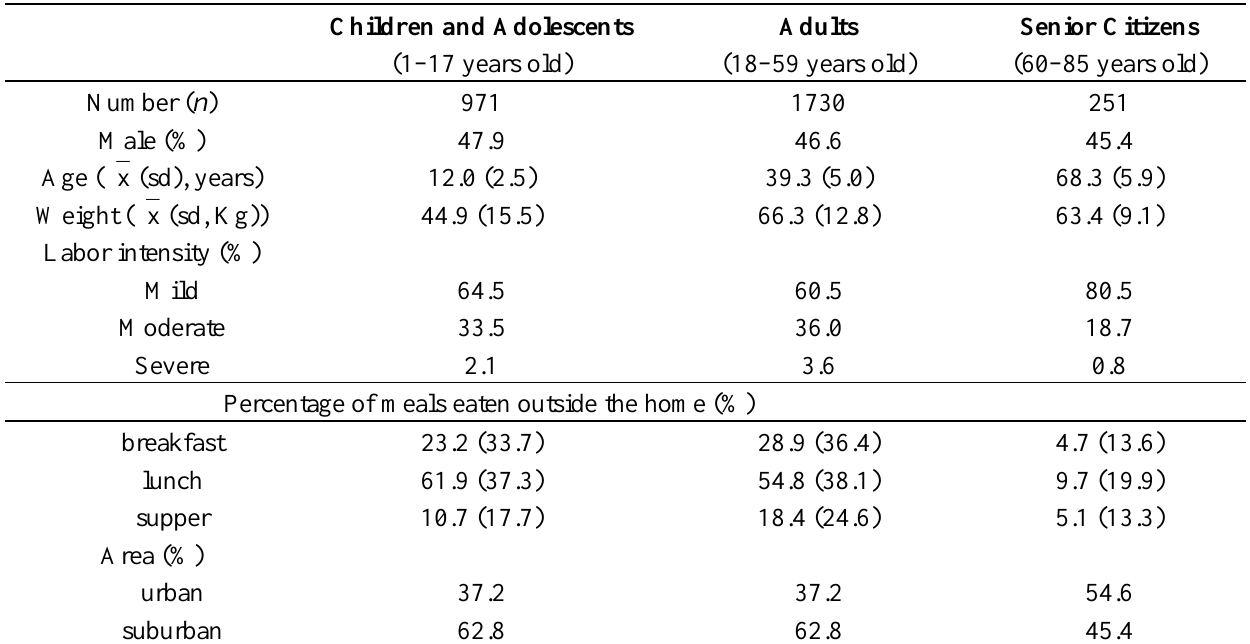
Table 1. Basic characteristics of